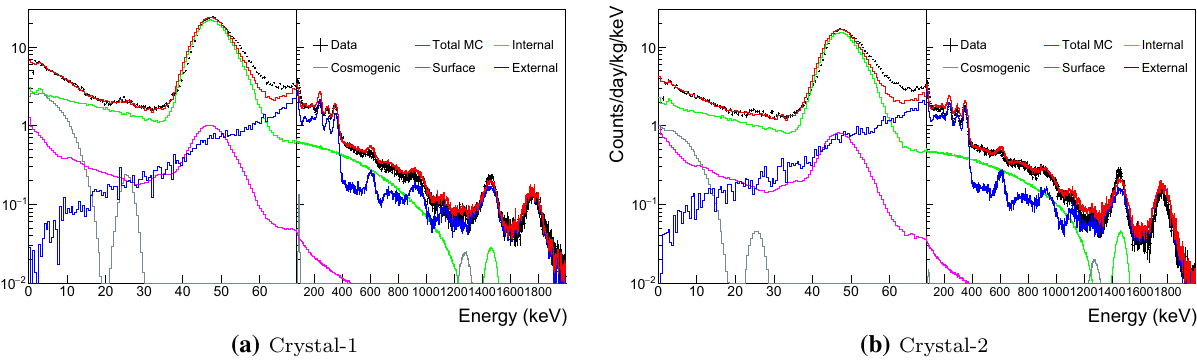
Fig. 3 Measured single-hit background spectra of Crystal-1 and Crystal-2 fitted with all simulated background spectra. 3 H and 109 Cd are included in the